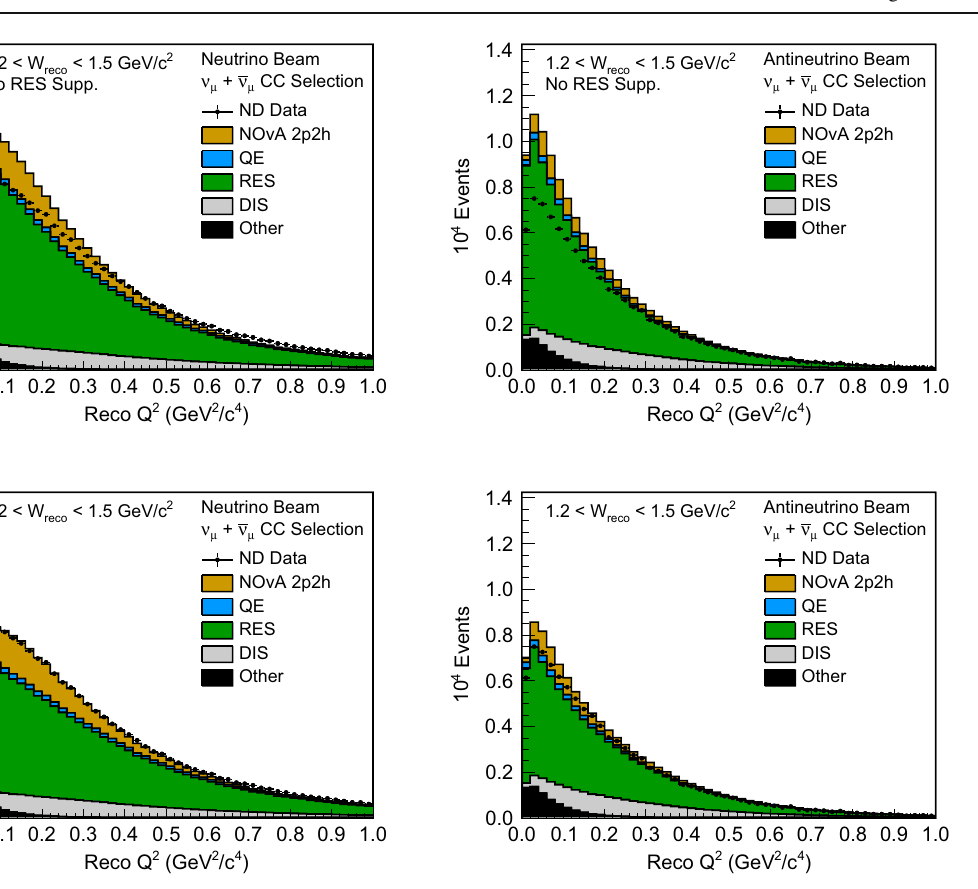
applied, including the addition of the fitted 2p2h described in Sect. 4.3, except that the RPA-like low- Q 2 suppression is not applied to RES interactions in the top plots. Neutrino beam is shown at left, antineu- trino beam at right